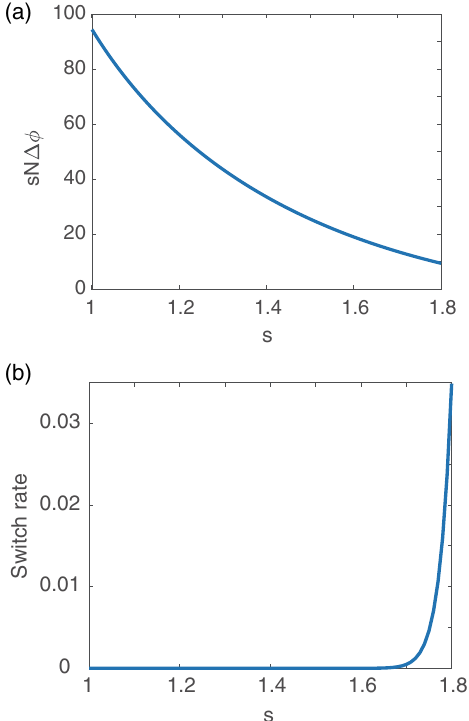
FIG. 11. Shift of the N probability distribution in unistable m autophosphorylation mutant strains with the progress of time. FIG. 12. Simulation results for Rad53 overexpression strains. (a) Dependence of the switch rate on the overexpression scale s . ˜ ϕ (b) Relationship between N Δ and s . The parameters for s ¼ 1 are chosen to be the same as the setting for sml 1 Δ strains, and the concentration of HU stimulation is set as 0.7 mM. The saturation switch rate observed in the experiment is around 0 . 01 min − 1